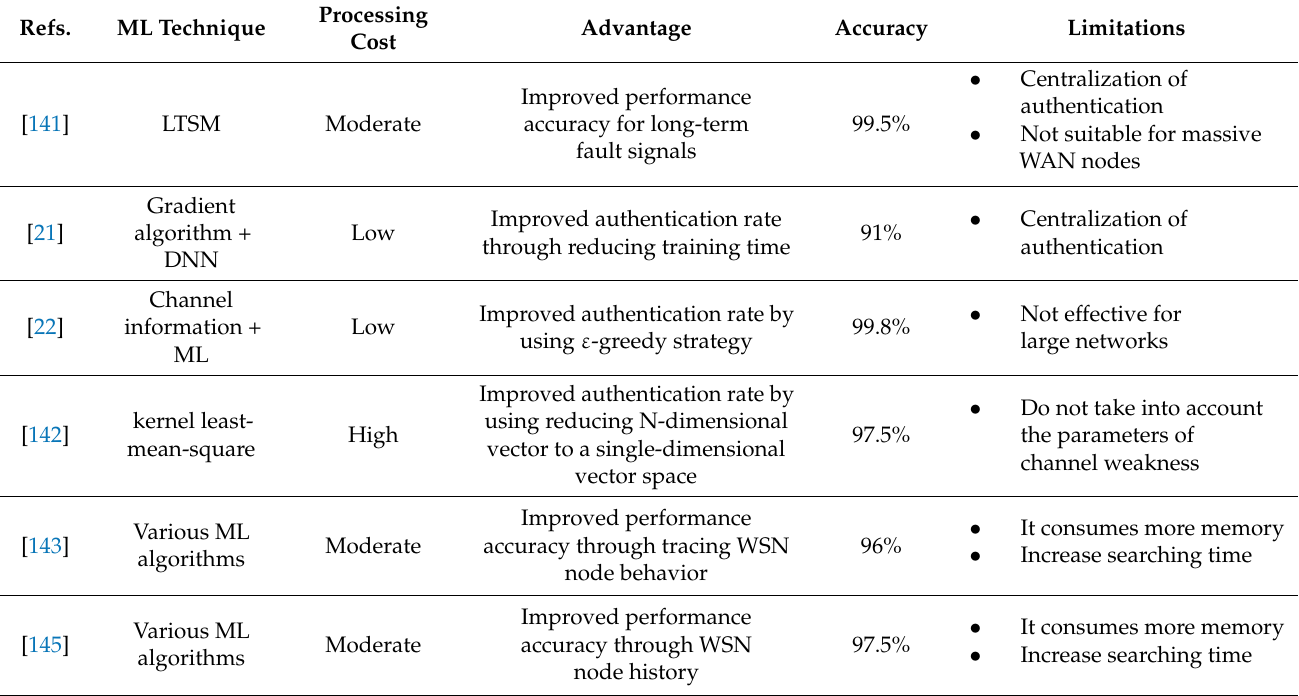
Table 7. Summary of reviewed ML algorithms in the authentication.